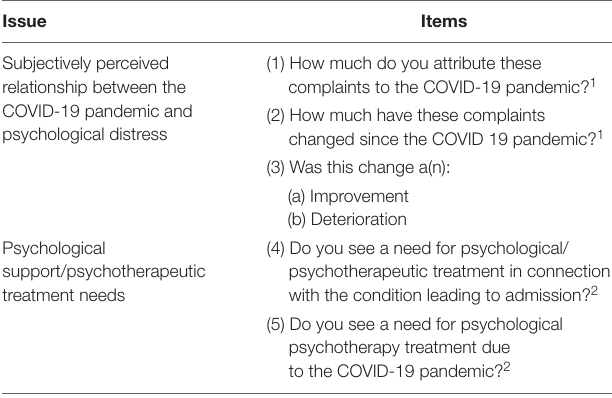
TABLE 1 | Questions regarding the relationship between psychological distress and the COVID-19 pandemic.